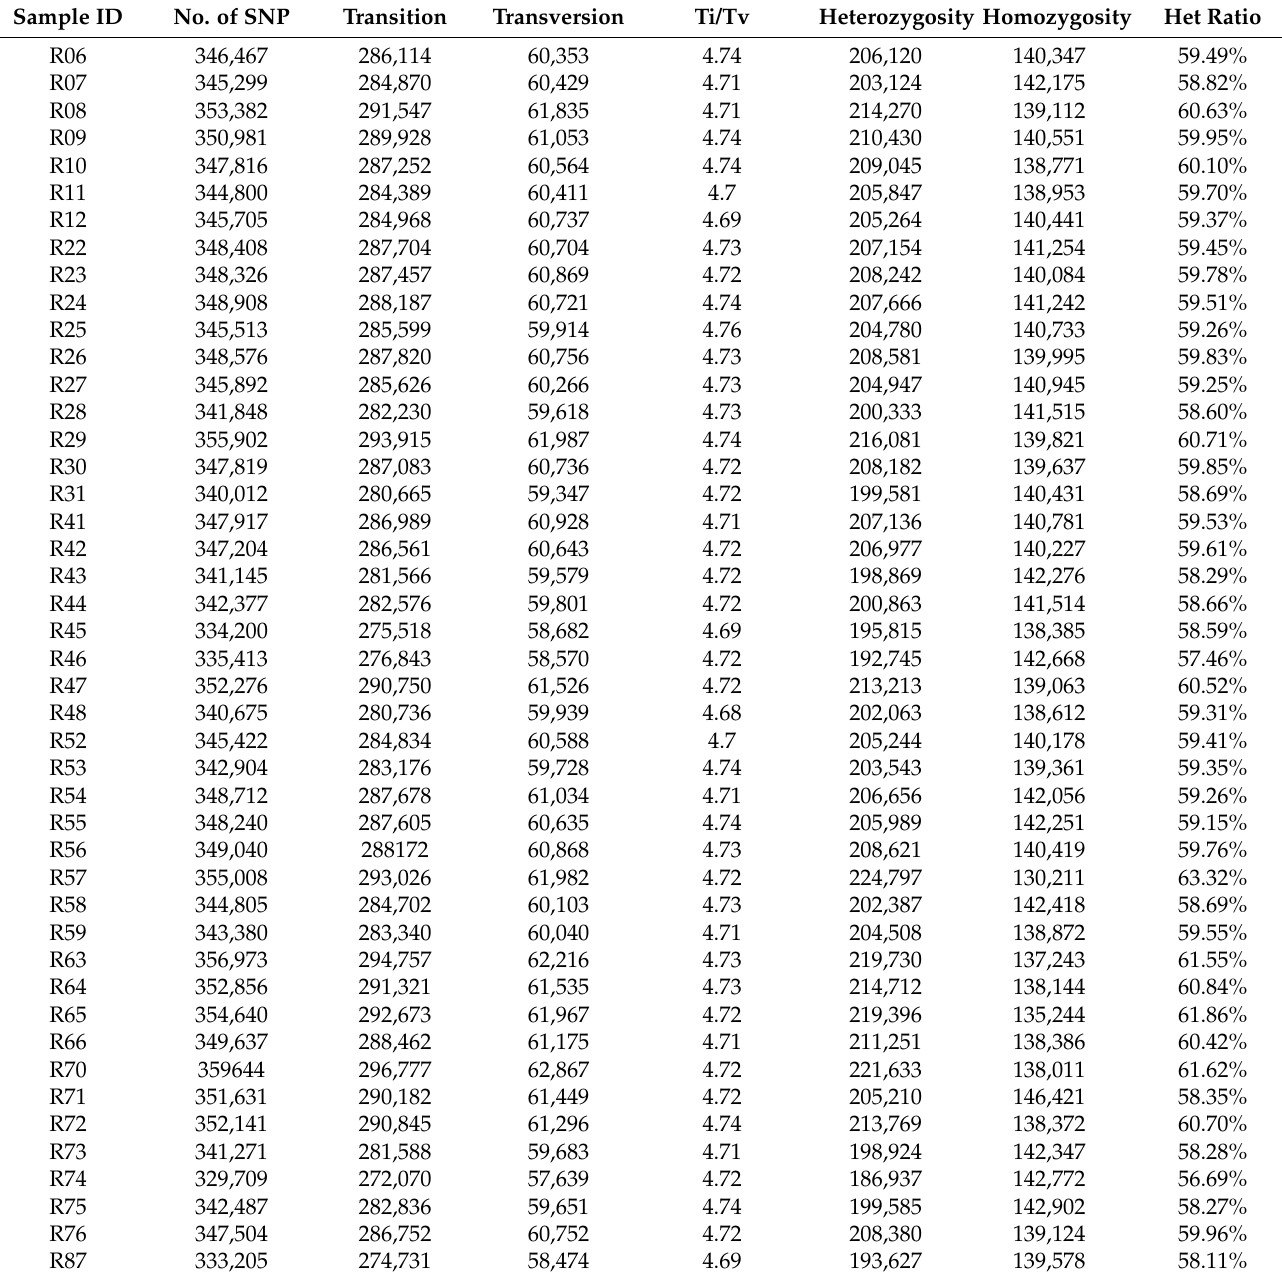
Table A1. The number of SNPs and mutation statistics detected in 45 resistant individual samples in A. c. cerana